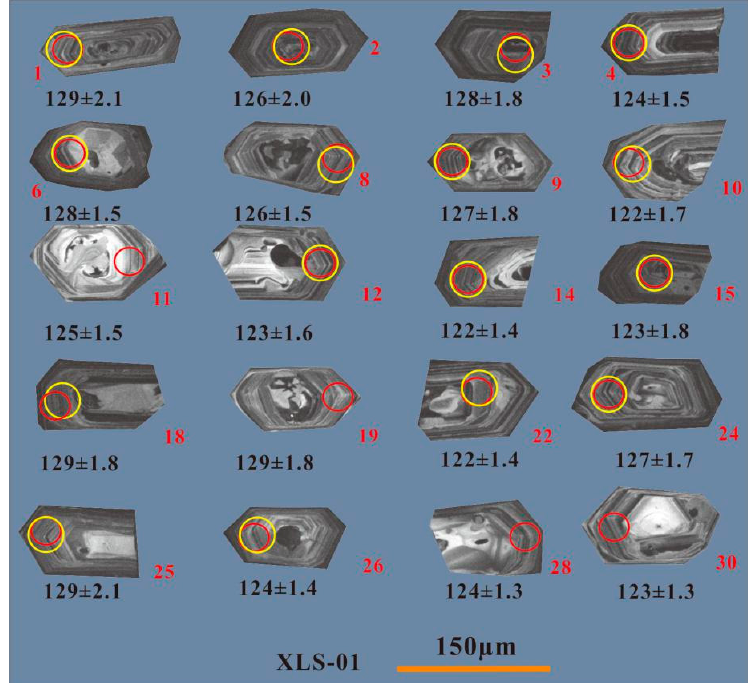
Figure 3. Representative zircon CL images of the Xianglushan biotite granite (sample XLS01-01). The yellow and red circles denote the Hf and U-Pb isotopic analysis spots, respectively.